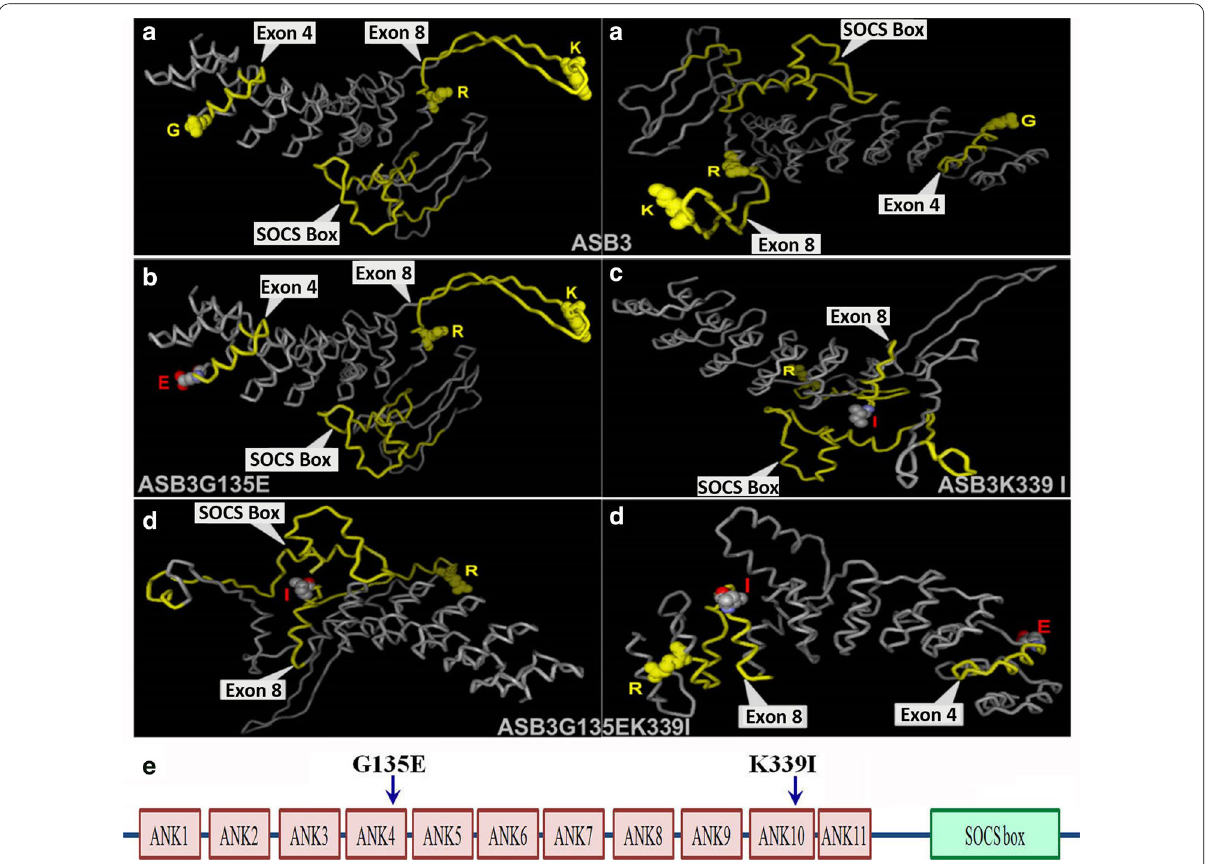
Fig. 6 Comparison among three‑dimensional (3D) models of WT ASB3 and ASB3 mutant proteins by computer homogeneity modeling and prediction with the SWISS‑MODEL. The ASB3/ASB3 mutant proteins were modeled and predicted. a Images of spatial structure of ASB3 from two different angles. b Image of 3D model of G135E (ASB3G135E, on the left ). c Image of 3D model of K339I (ASB3K339I, on the right ). d Images of spatial structure of G135E/K339I (ASB3G135EK339I) from two different angles. e Structure sketch of ASB3 protein with G135E and K339I